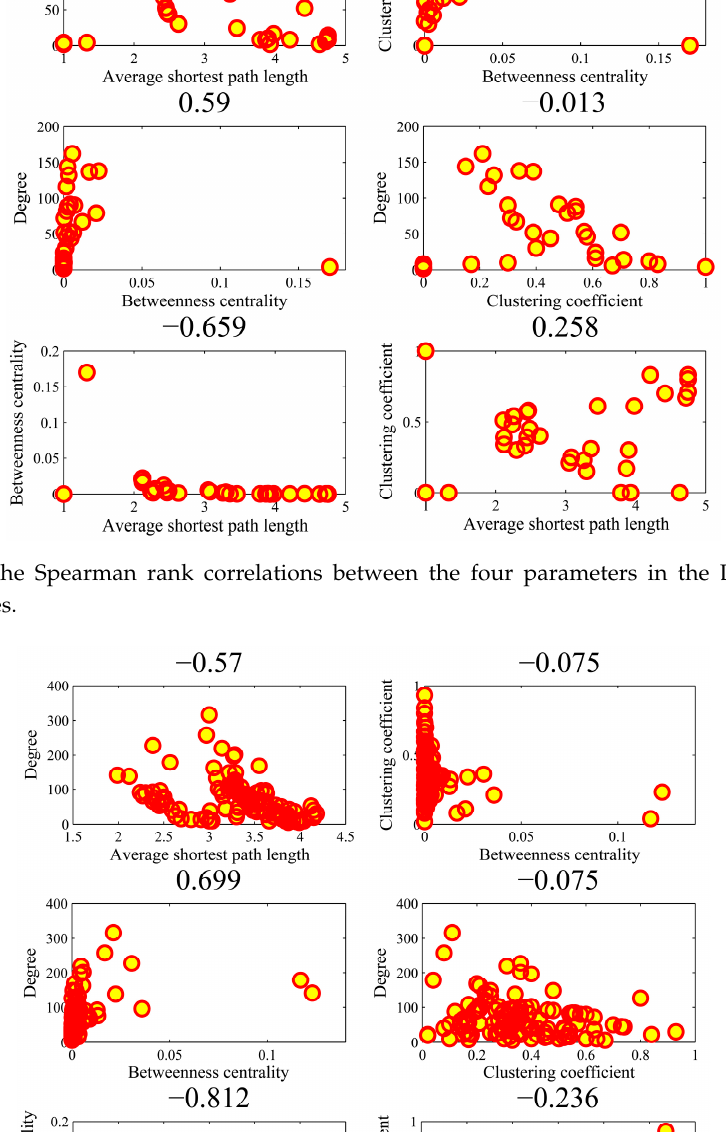
Figure 10. The Spearman rank correlations between the four parameters in the AD (Alzheimer’s disease) genes.